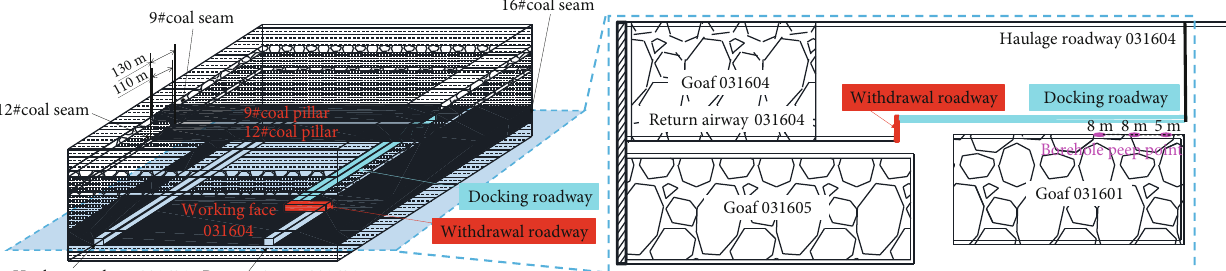
Figure 1: Spatial position relationship of coal seam and roadway.